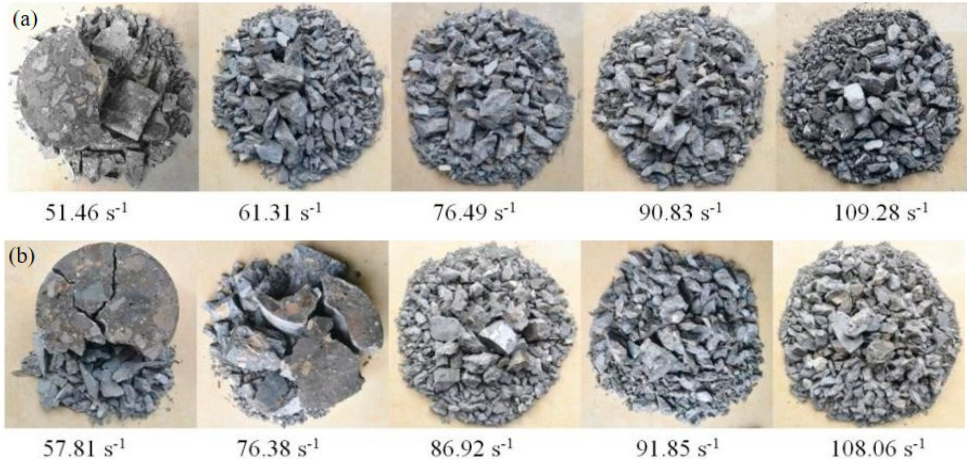
Figure 10. Typical failure mode of concrete under different strain rates ( a ) PC; ( b ) CNFC02.